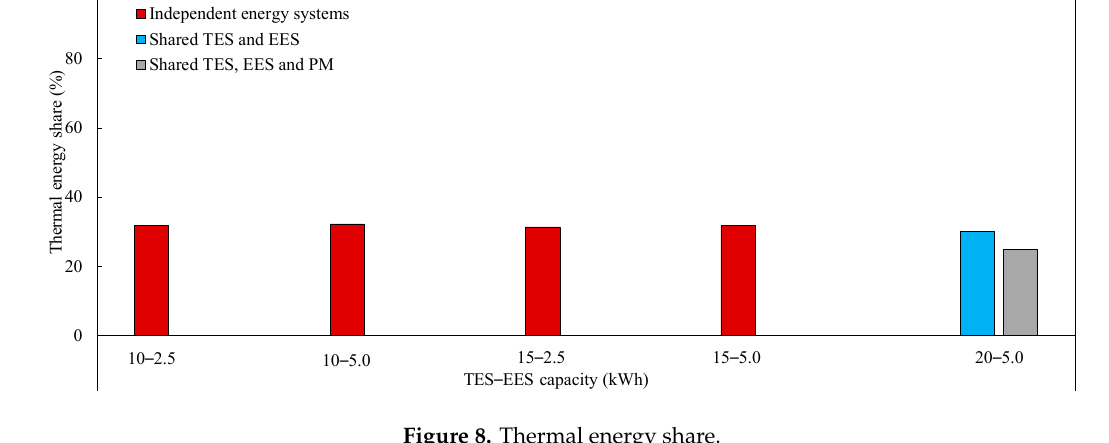
Figure 8. Thermal energy share.